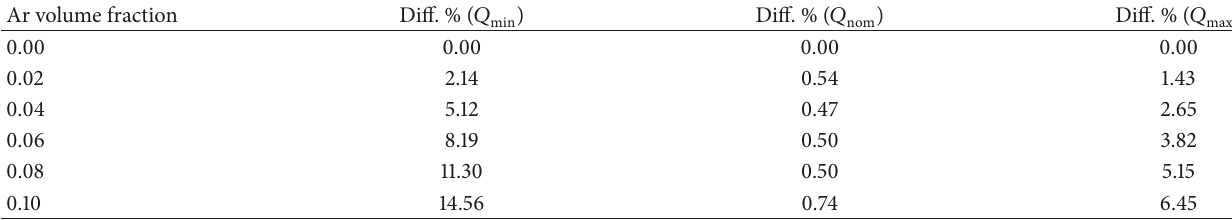
Table 2: Percentage differences for multiphase